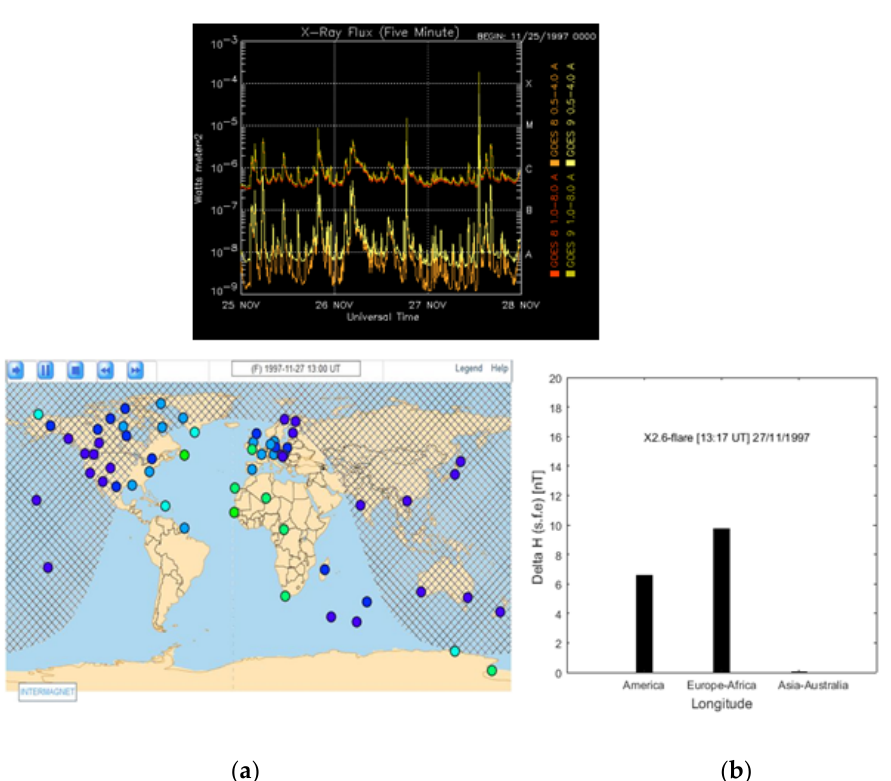
Figure 4. X-ray flux of X2.6 solar flare of 27 November 1997 (www.speaceweather.com/archive.php, accessed on 1 November 2021). The illuminated part of the Earth during this solar flare of 27 November 1997, is shown in Figure 4, with noon in UT closer to Europe-Africa longitude sector (on top ) and below . Day and night alternation Source INTERMAGNET ( a ) and histograms of the average variations of magnetic crochets in South and North America, Europe-Africa and Asia-Australia longitude sectors from 11 November 1997 at 13:17 UT ( b ).